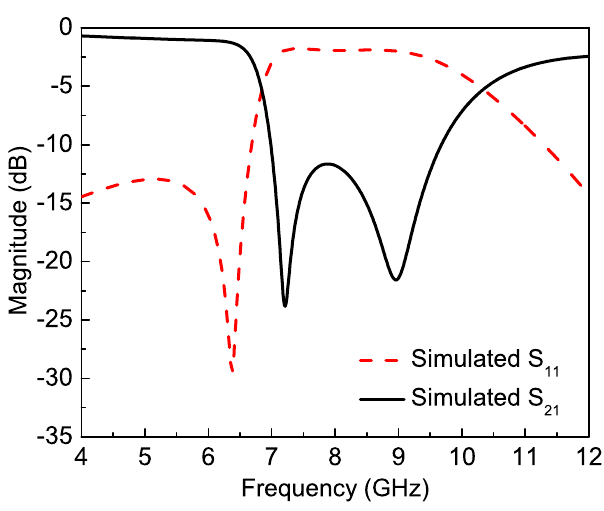
Figure 2. The magnitude of transmission ( S 21 ) and reflection ( S 11 ) coefficients for the metaresonator sensor. The first and second notches have a resonance at 7.21 GHz with notch depth − 23.85 dB and 8.97 GHz with notch depth − 21.57 dB.